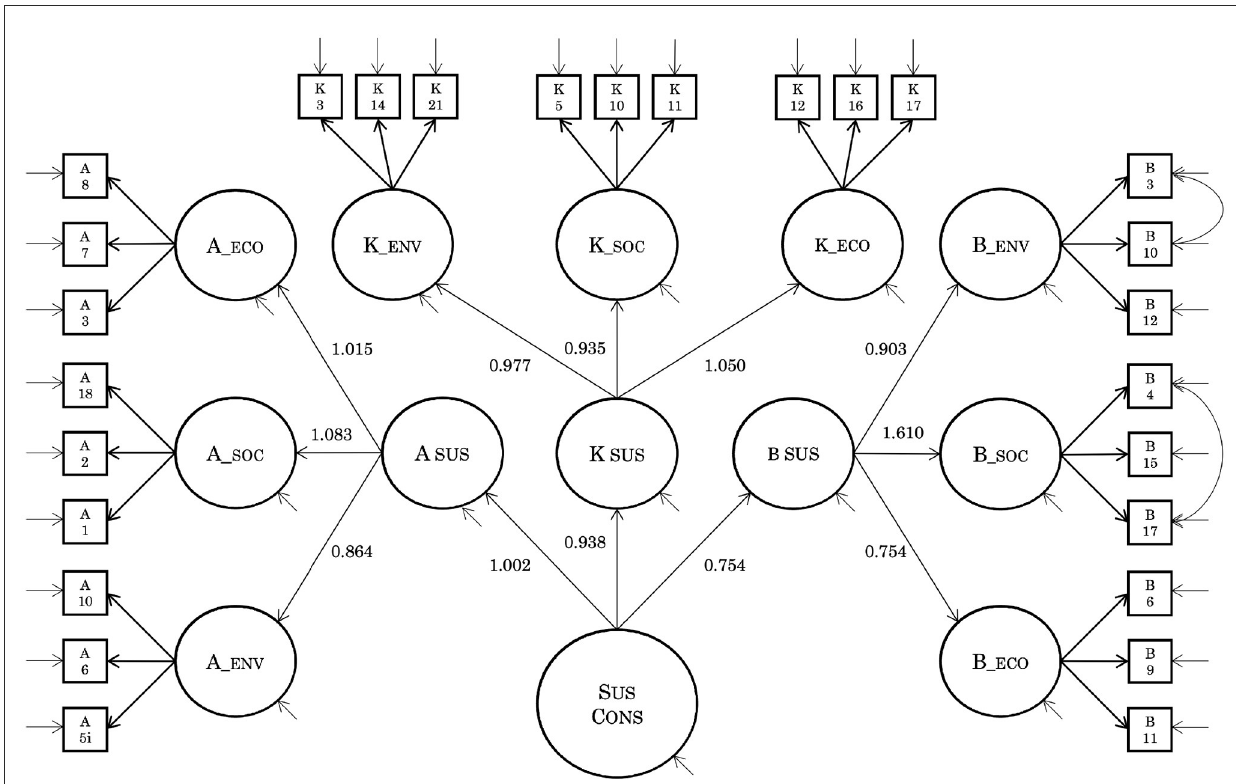
FIGURE2 Result of fitting the factor structure of the original version of SCQ to the data in Study 1. The characters in squares (e.g., A5i) indicates the item code in the original study of SCQ (see Supplementary Table 1 for details). Measurement errors are omitted from the notation. When items are connected by an arrow, an error correlation is assumed between them, following the original factor model. K, knowingness; A, attitudes; B, behavior; ECO, economic; SOC, social; ENV, environmental; SUS CONS, sustainability